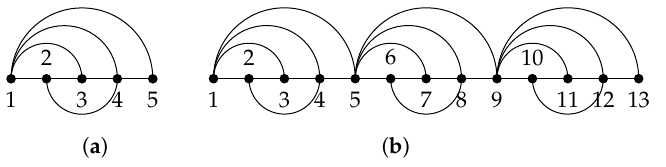
Figure 2. ( a ) Basic graph G = ( V , E ) [26]. ( b ) Periodic graph with P = 3 replicas G P = ( V P , E P ) .